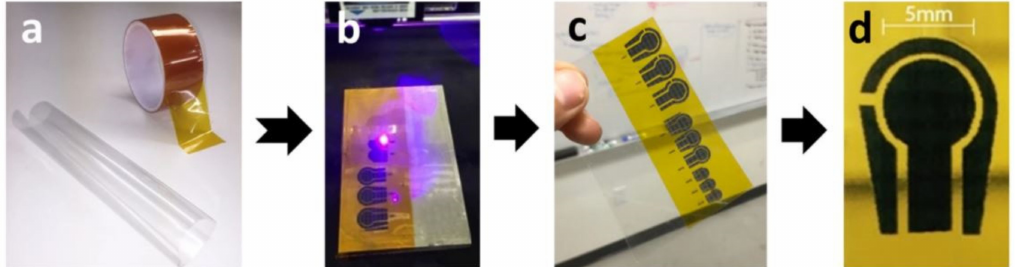
Figure 4. The fabrication process of the LIG-decorated sensors for the detection of glucose molecules [140]. ( a ) Raw materials included Kapton tape and PVC sheet. ( b , c ) The direct laser reduction of Kapton tapes to form graphene. ( d ) Formation of DREG-3 electrode platform. Copyright 2016 Springer